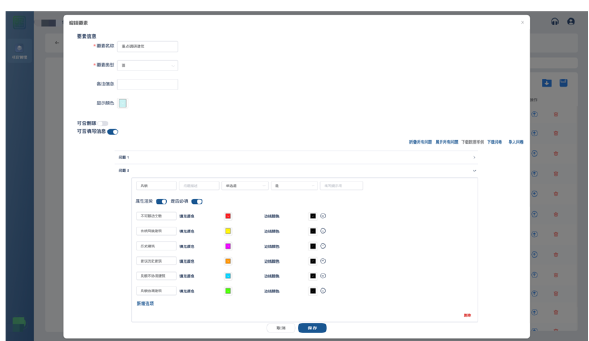
Figure 8 . Data Template